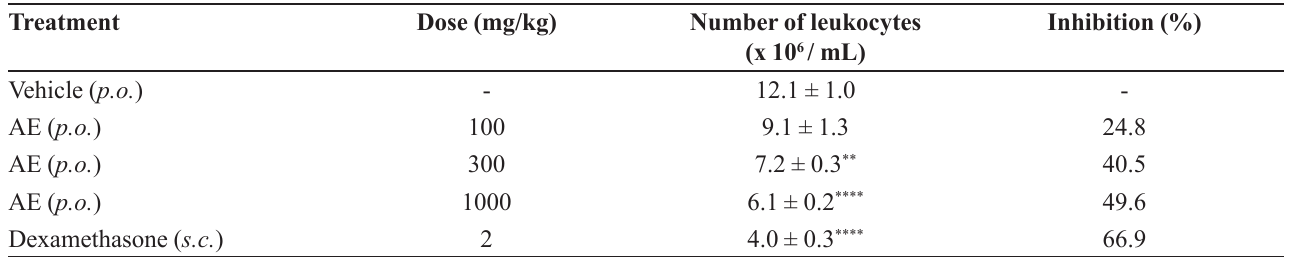
TABLE II - Effect of AE from Anacardium occidentale on carrageenan-induced peritonitis in mice Treatment Vehicle ( p.o.